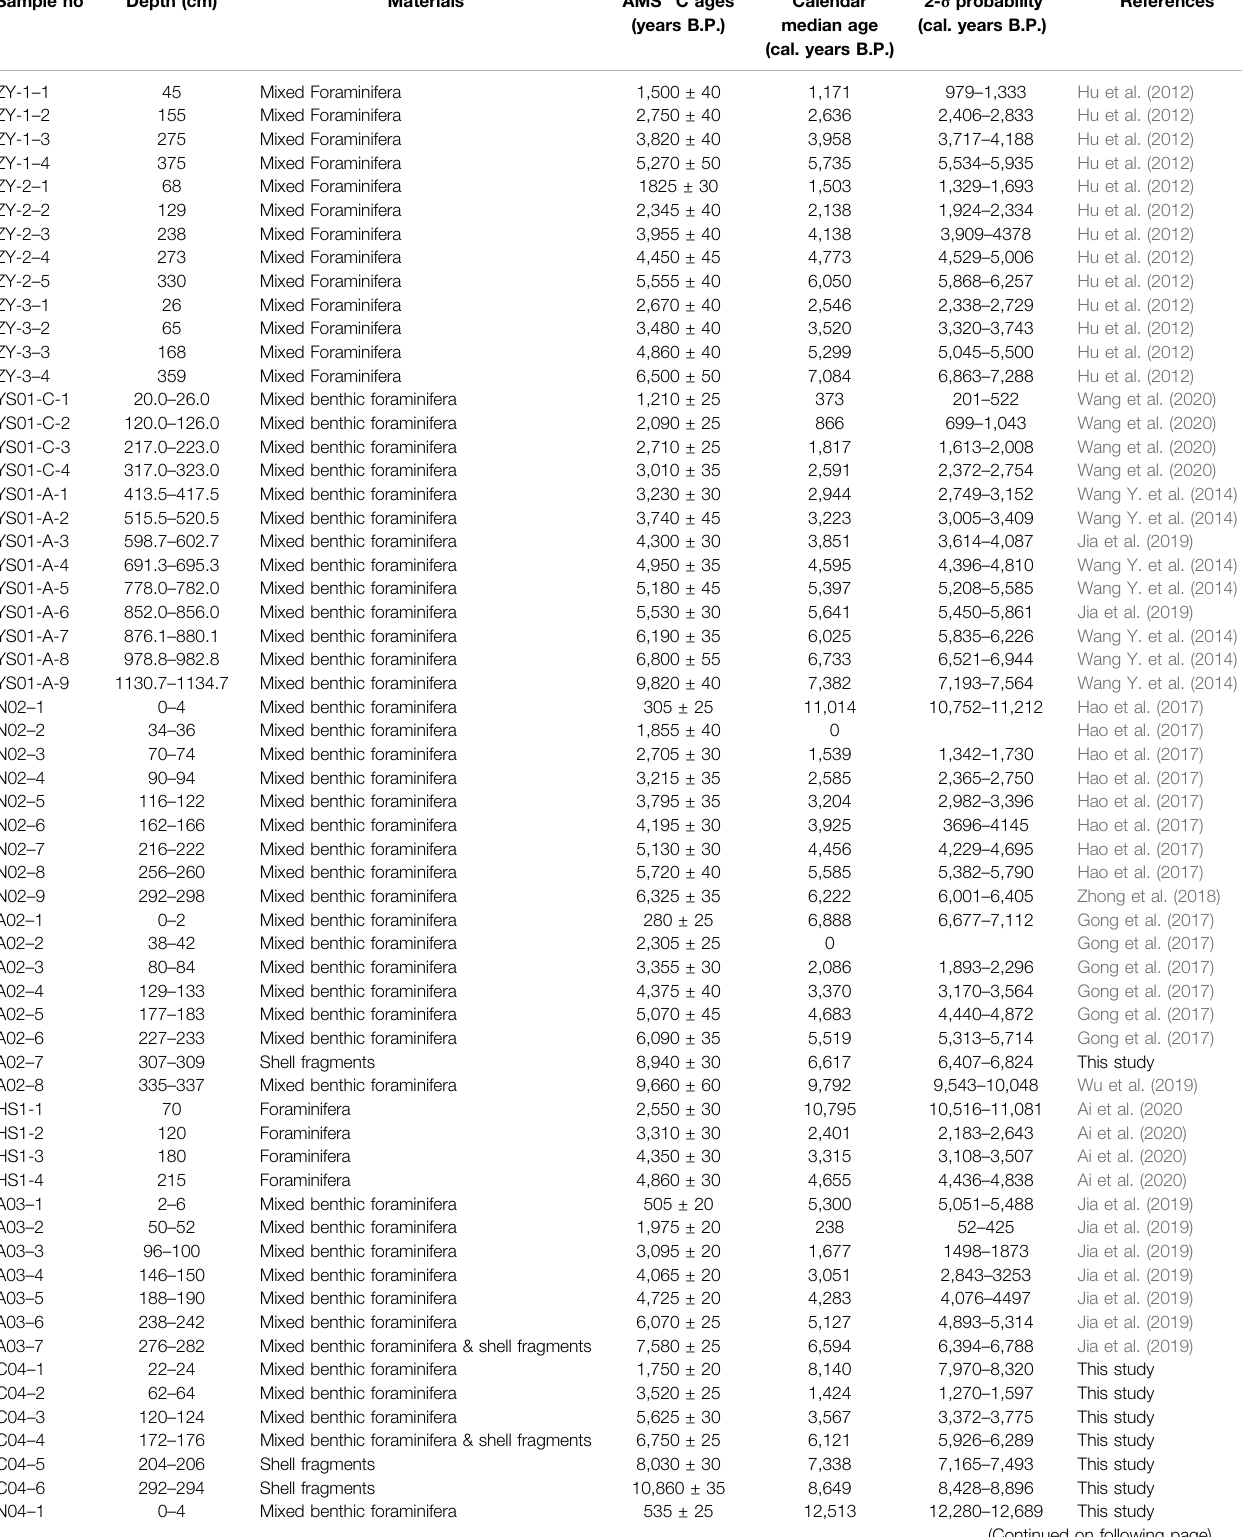
TABLE 2 | AMS 14 C age data and calibrated age data for cores used in this study, with re-calibrated age data for cores from references. Calendar ages were performed by the CALIB 8.2 program (Stuiver et al., 2021) and the Marine20 calibration curve (Heaton et al., 2020). Sample